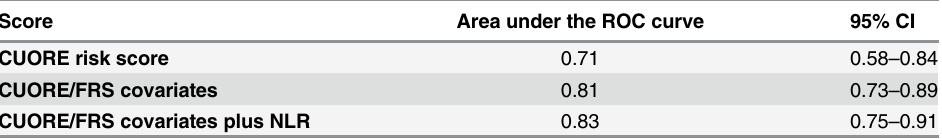
Table 3. Areas under the ROC curve according to different risk scores of CVD